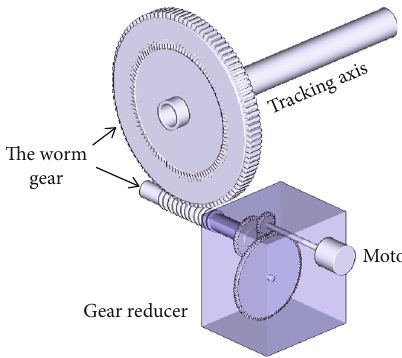
Figure 22: Worm wheel type reducer with a pinion reducer.